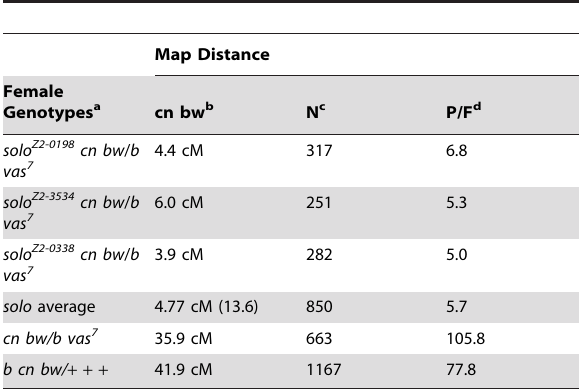
Table 5. Sister chromatid exchange is increased in solo